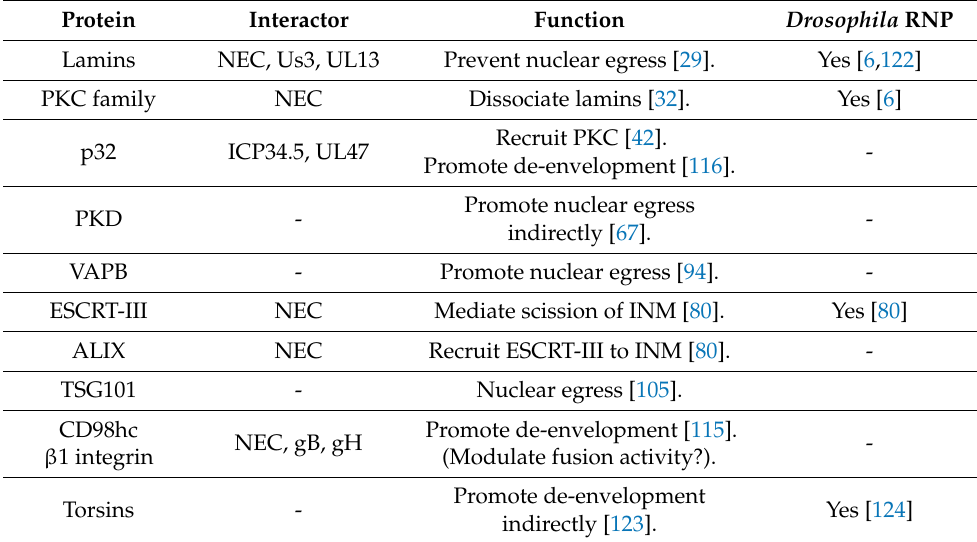
Table 2. Cellular factors involved in nuclear egress of HSV